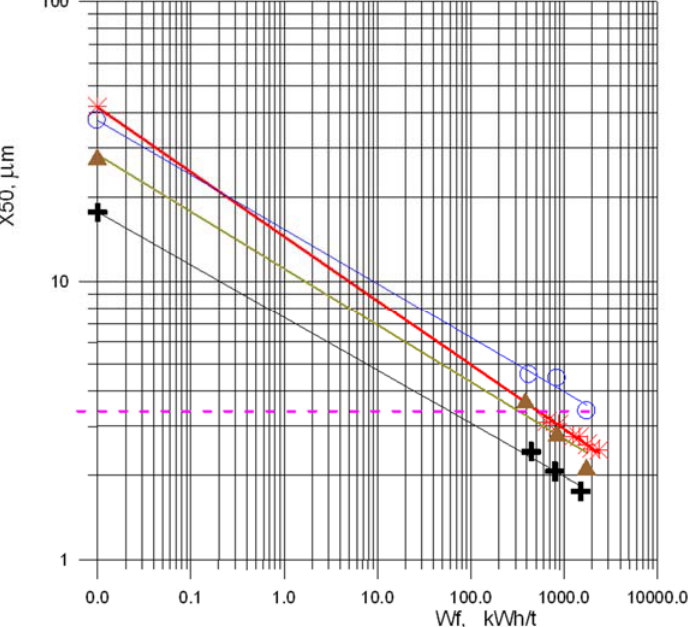
Figure 3. Relationship between grinding fineness and specific grinding work for different materials. (Notations: + limestone, ▴ andesite, ○ pumice, × tailings of ore processing) [4].